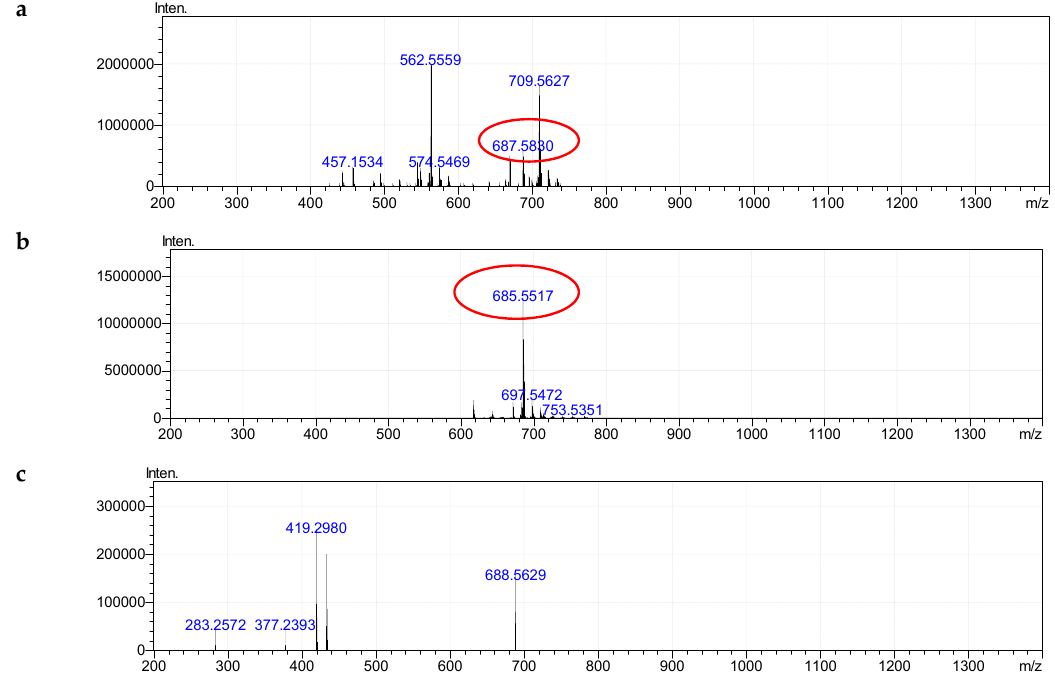
Figure 9. Fragmentation of CAEP (37:1): a —MS + , b —MS − , c —MS 2 − .